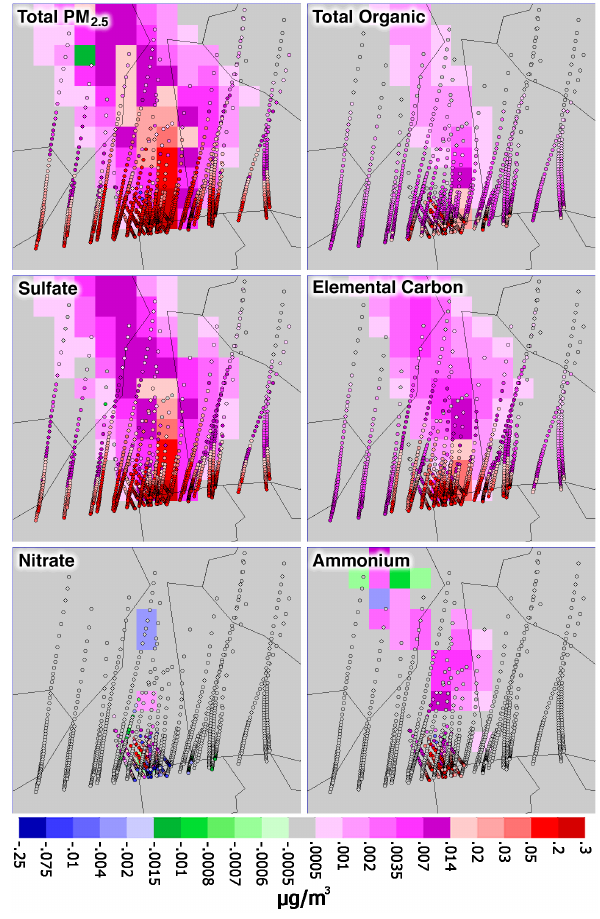
Fig. 5. Concentrations of six species due to aircraft in puffs and in grid cells (in all vertical layers) on 6 June at 11:00UTC. Each panel shows a 52km by 56km area centered slightly north of the airport. Puffs and grid cells share the same color